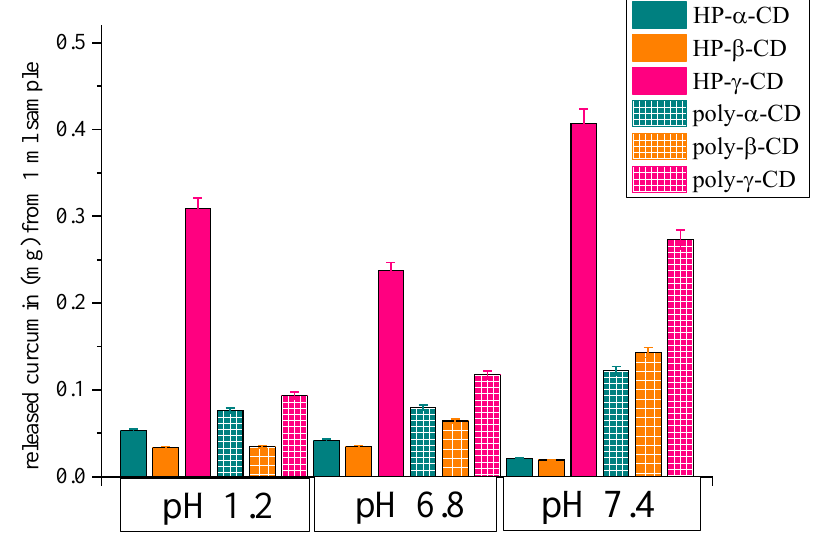
Figure 8. The released amount of curcumin (mg) from 1 mL CD complex sample at three stages of model gastrointestinal tract; pH 1.2, 6.8 and 7.4 corresponds to simulated gastric, intestinal, and colonic fluid,